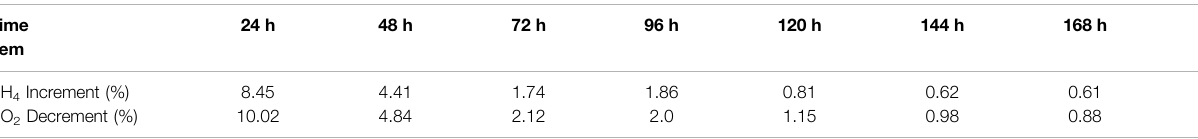
TABLE 5 | The changes of CH 4 and CO 2 concentration in Experiment 4.